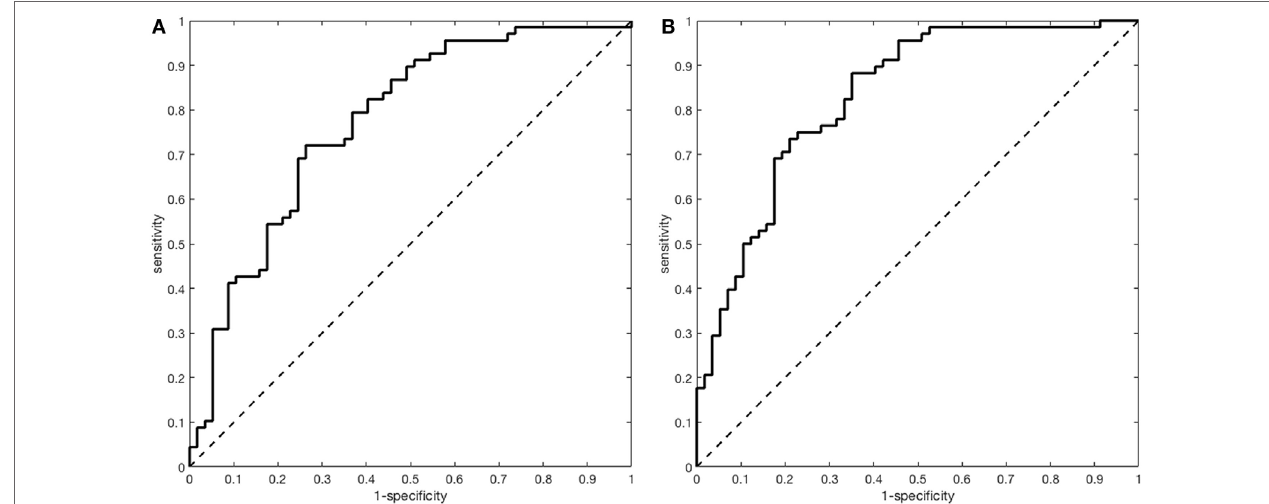
FigUre 2 | Receiver operating characteristics analyses for the prediction of good functional outcome in the subgroup with mild to severe stroke. (a) Multivariate model with National Institutes of Health Stroke Scale (NIHSS), age, and ischemic heart disease [area under the curve (AUC) = 0.77; 95% CI 0.77–0.86]. (B) Multivariate model with NIHSS, age, ischemic heart disease, and relative reduction NIHSS (AUC = 0.83; 95% CI 0.76–0.90).